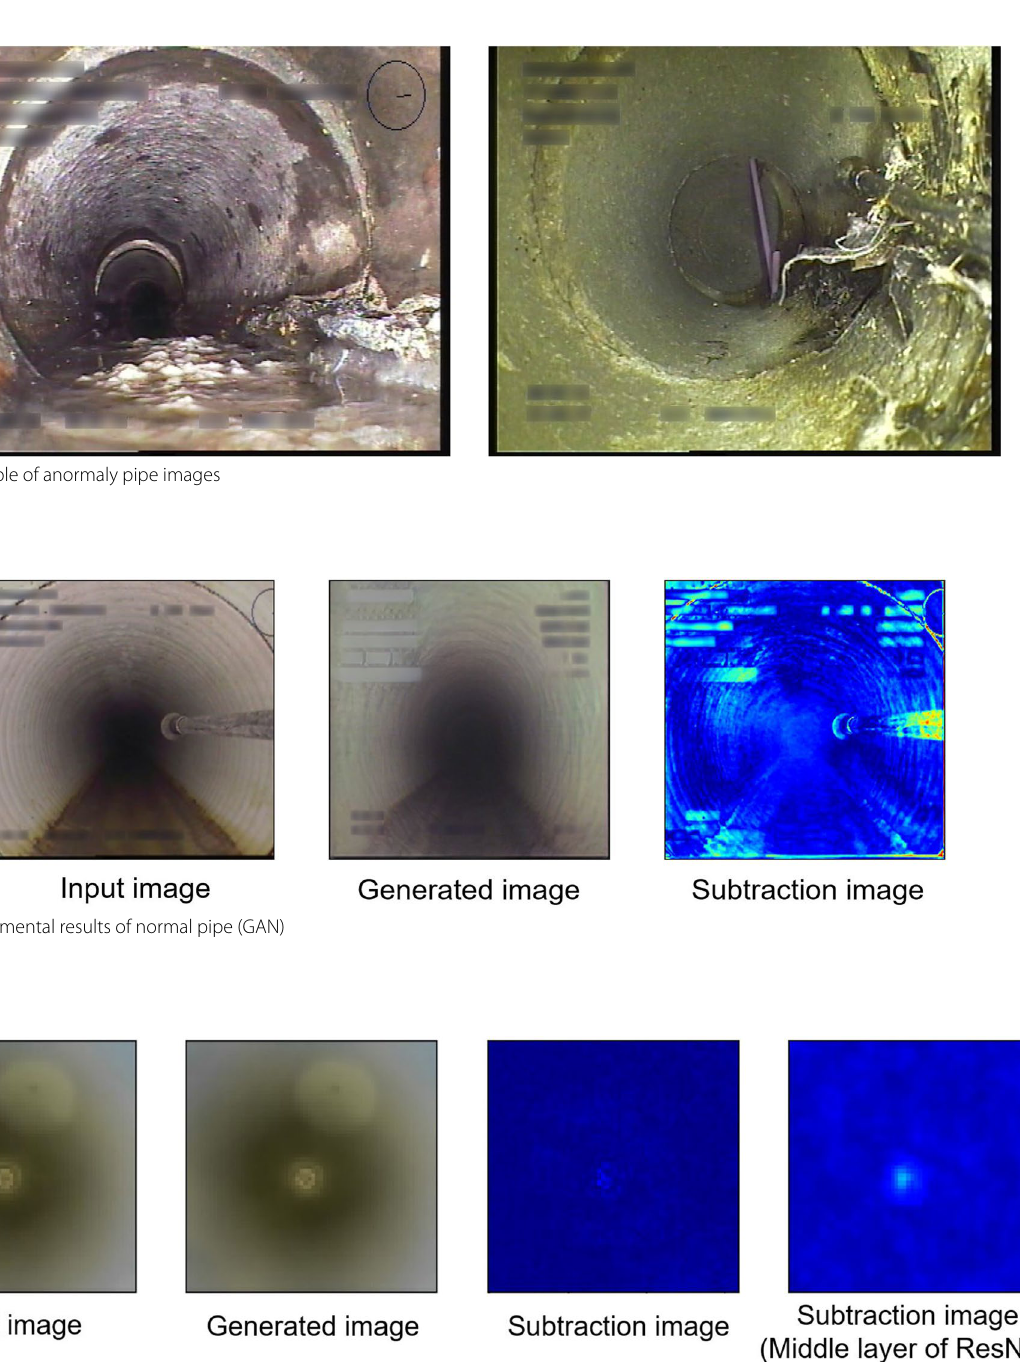
Fig. 20 Experimental results of normal pipe